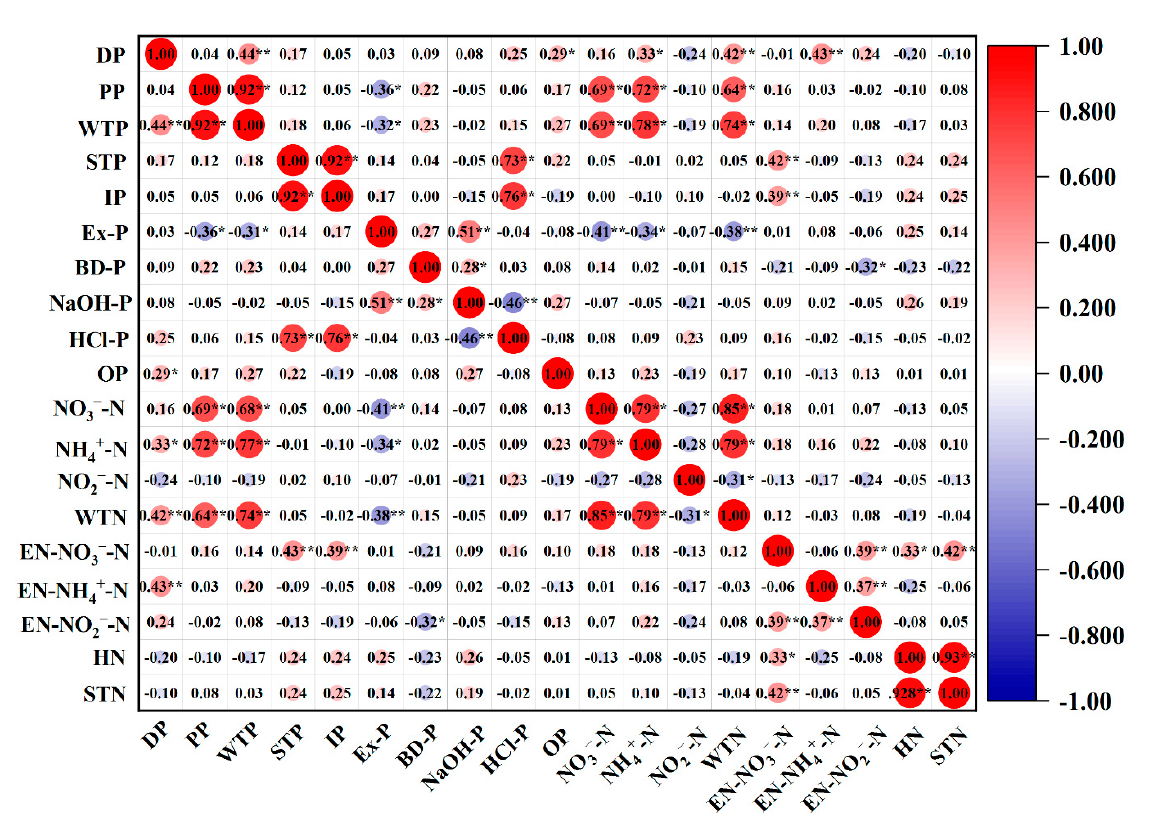
Figure 10. Correlation between different N and P in the study area (**: Correlation is significant at the 0.01 level, *: Correlation is significant at the 0.05 level.).